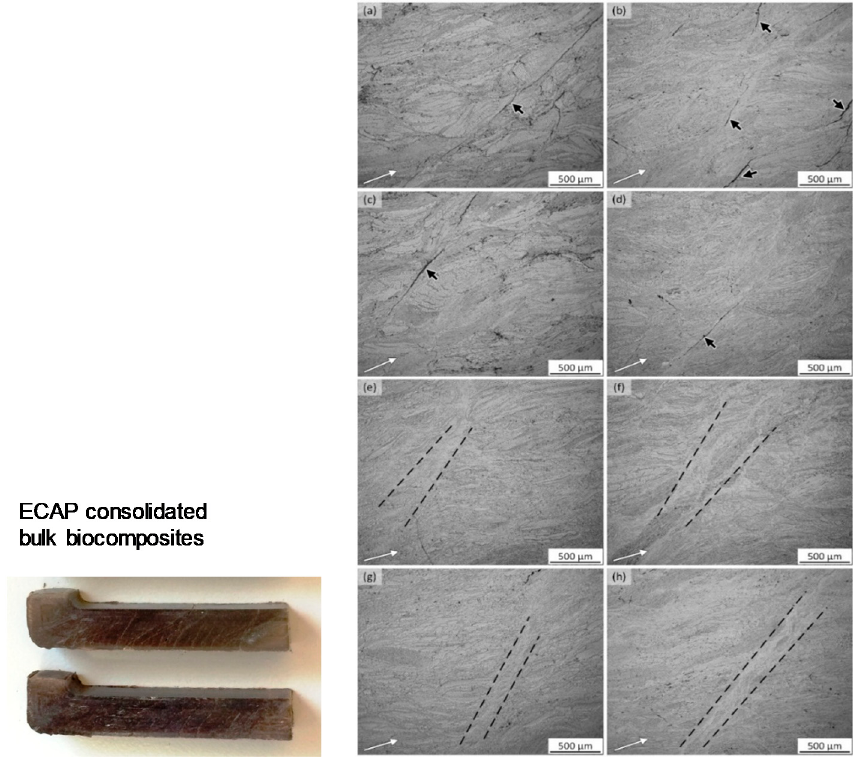
Figure 4. Typical equal channel angular pressing (ECAP) consolidated samples (left) and their optical images of microstructures showing regions with cracks (black arrows) in ( a ) HW/PEI, ( b ) HW/PEI/TA, ( c ) HW/PEI:A, ( d ) HW/PEI/TA:A, and shear bands (between dashed lines) in ( e ) HW/PEI:M, ( f ) HW/PEI/TA:M, ( g ) HW/PEI:(A + M), ( h ) HW/PEI/TA:(A + M). The white arrows mark the general particle orientations. The pressing direction is horizontal to the right.